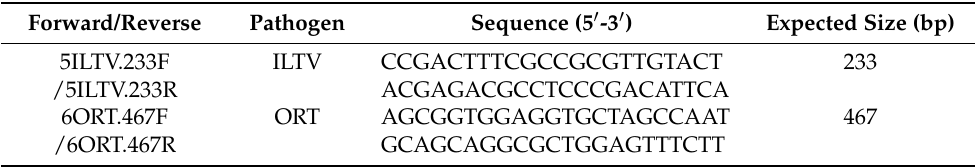
Table 1. Sequences of primers designed in this